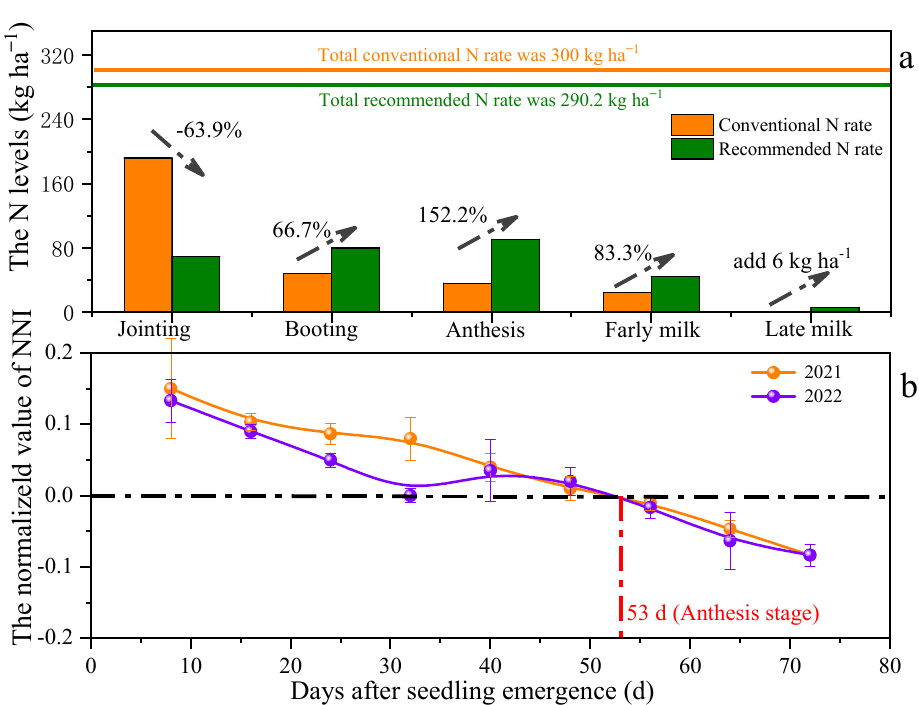
Figure 7. ( a ) Comparison of the recommended fertilization strategy and conventional fertilization strategy. ( b ) Evaluation of the recommended fertilization strategy using NNI. The normalized value of NNI (NNI − 1) was calculated by NNI values subtracting 1. The black numbers represent the percent change between the recommended and conventional N applications in different growth stages of wheat.